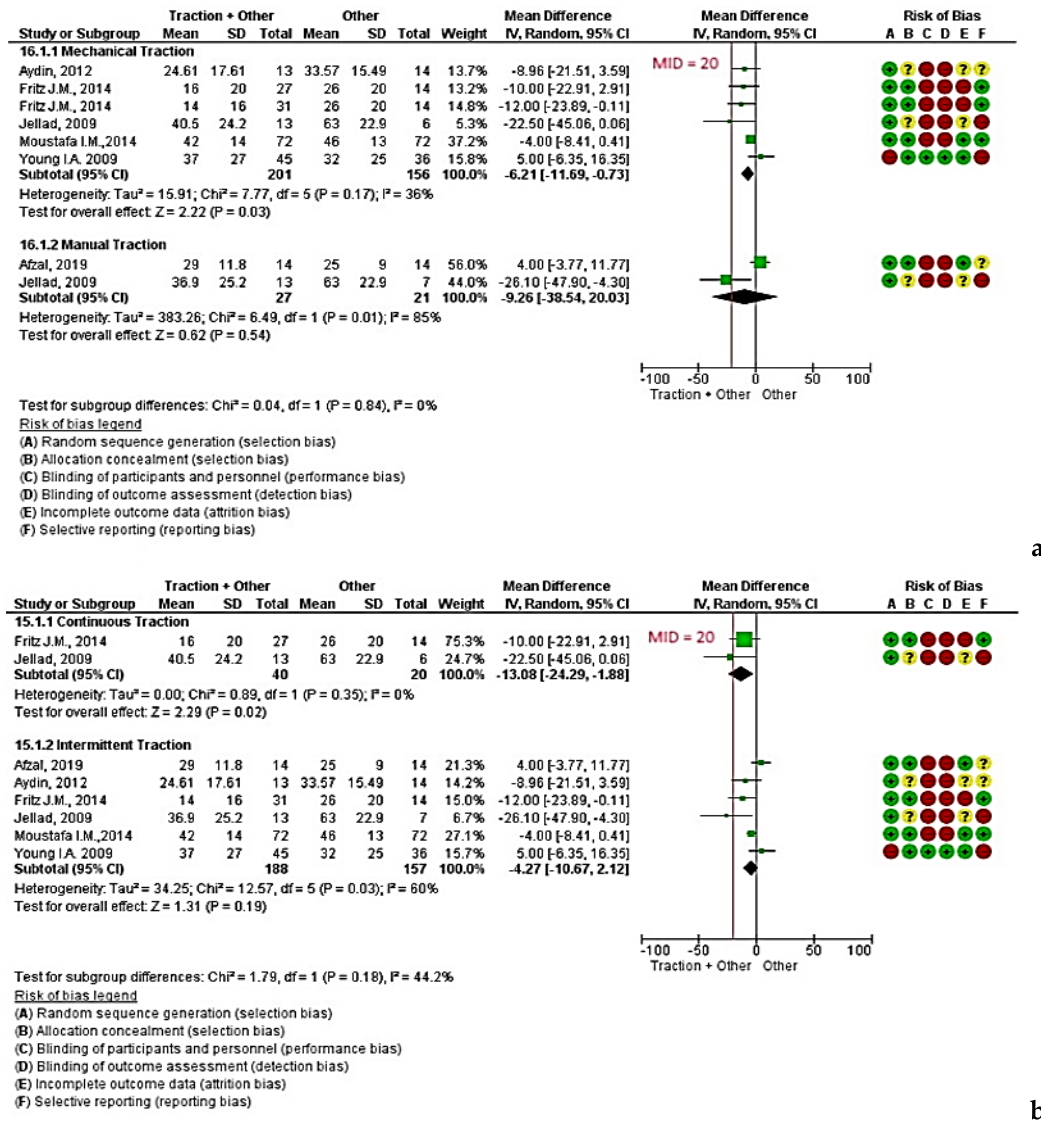
Figure 6. ( a ) Mechanical and manual traction versus control; ( b ) continuous and intermittent traction versus control. Legend: Red (-) = high risk of bias; Yellow (?) = unknown risk of bias; Green ( + ) = low risk of bias.